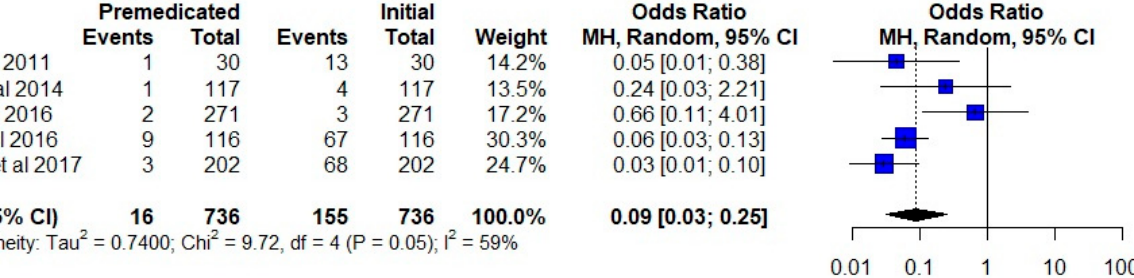
Figure 4. Comparison of the initial event rate versus the premedicated event rate in the same group of patients. The studies are shown with point estimates of the odds ratios and 95% confidence intervals. [29,26,30,28,27].